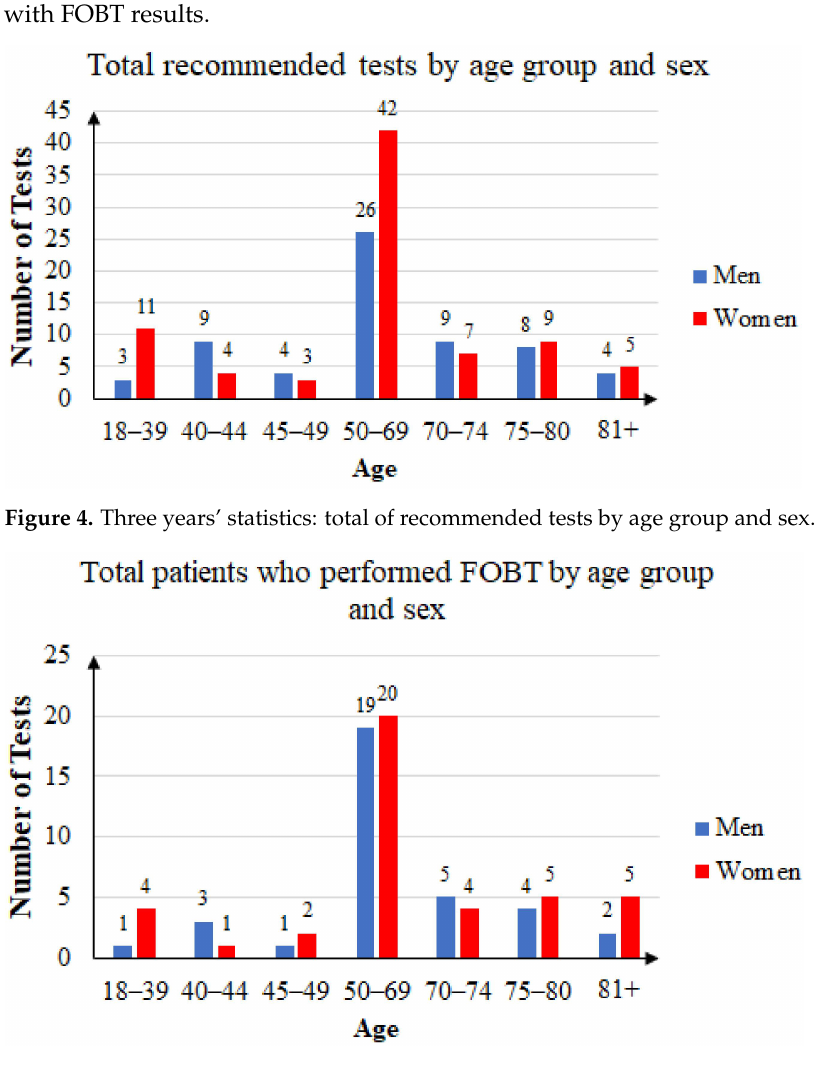
Figure 5. Three years’ statistics: total patients who performed FOB tests by age group and sex. Of the 76 unique patients who came back with an FOBT result, 41 were women (53.95%) and 35 were men (46.05). Of those patients, 15 had a positive FOBT result (19.73%), of which 10 were men (66.67%) and 5 were women (33.33%). The age distribution is presented in Figure